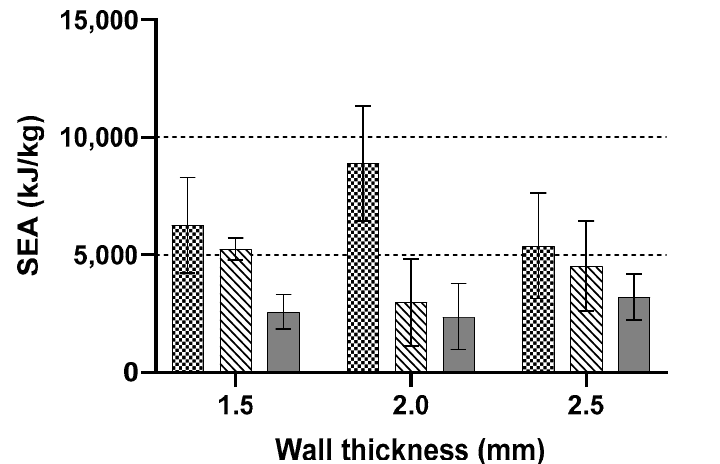
Figure 12. The comparison of EA for the same cell size with different wall thicknesses.